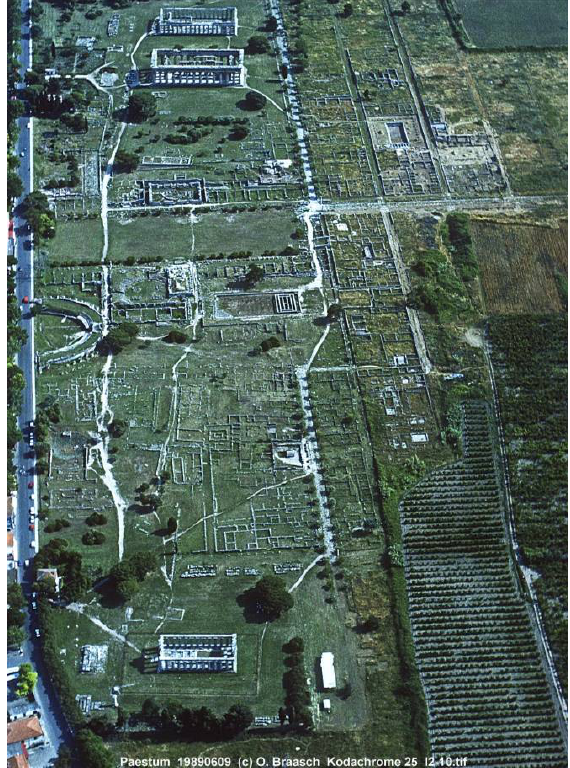
Figure 1: An aerial view in 1989 of the Paestum site (picture courtesy of Otto Braasch) which spans ca 700 x 350